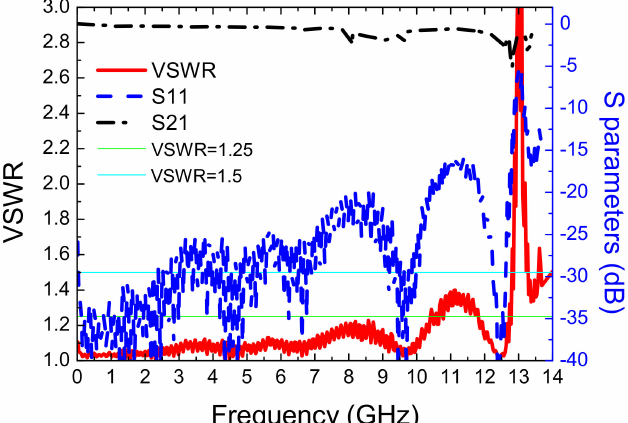
Figure 18. The manufactured scaled-down IC-Stripline cell based on image theory. The cover of the cell is removed.